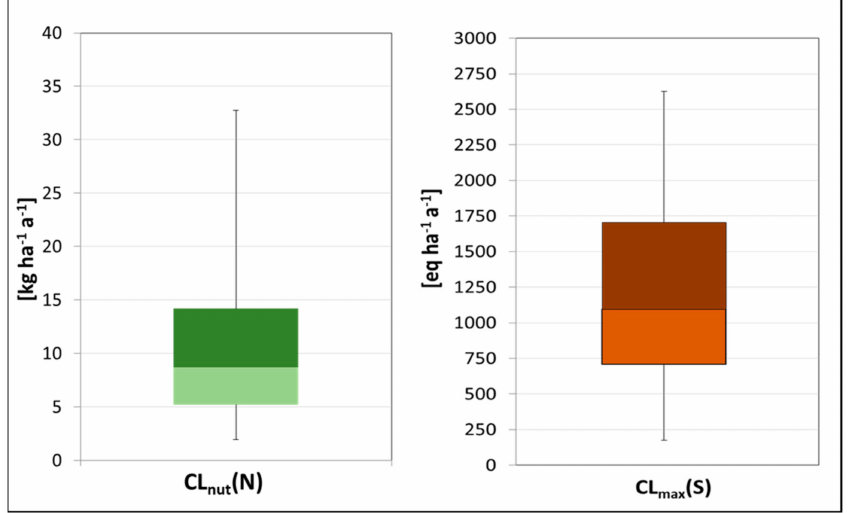
Figure 6. Statistics of critical loads for eutrophying nitrogen inputs (CL nut (N)) (left) and acidifying sulphur inputs (CL max (S)), created by the